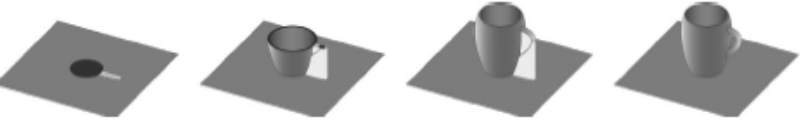
Figure 1. Basic principle of additive manufacturing. Reproduced from [20], 2012,